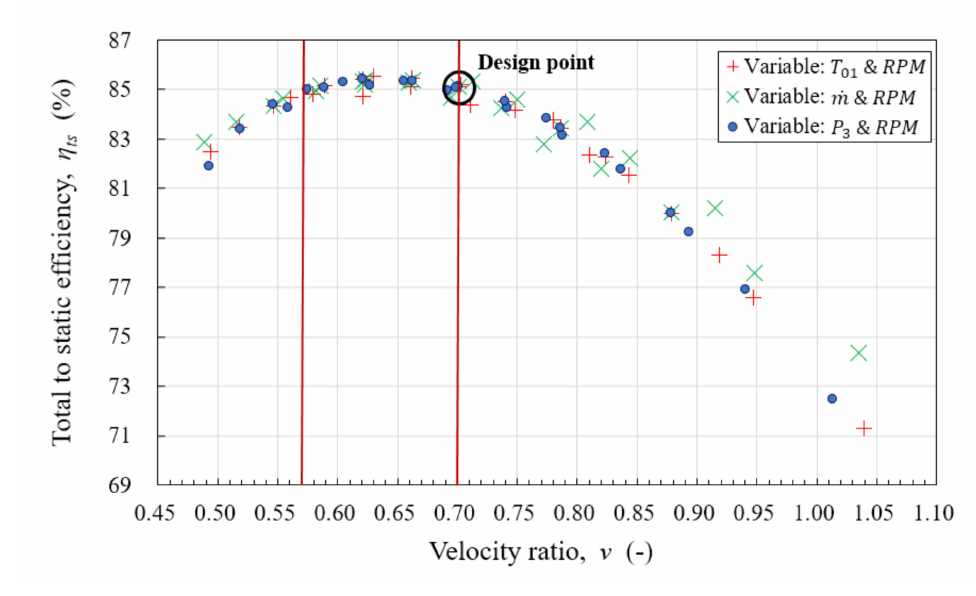
Figure 11. Total-to-static e ffi ciency according to the velocity ratio ( ν )